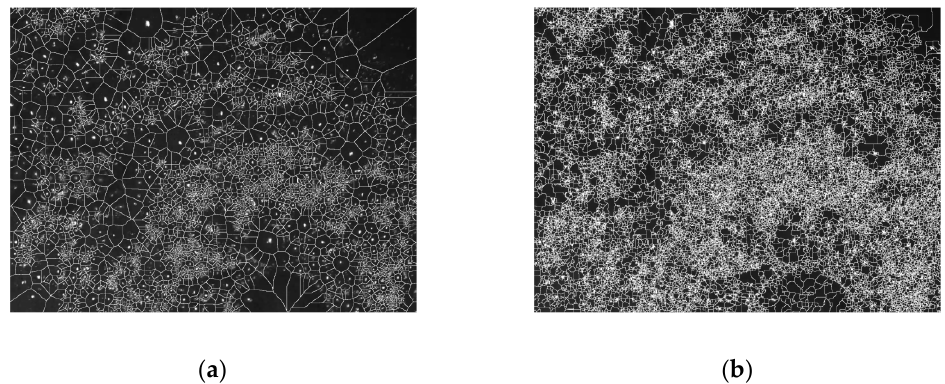
Figure 6. ( a ) The segmentation result of the improved watershed segmentation algorithm. ( b ) The segmentation result of the traditional watershed segmentation algorithm.